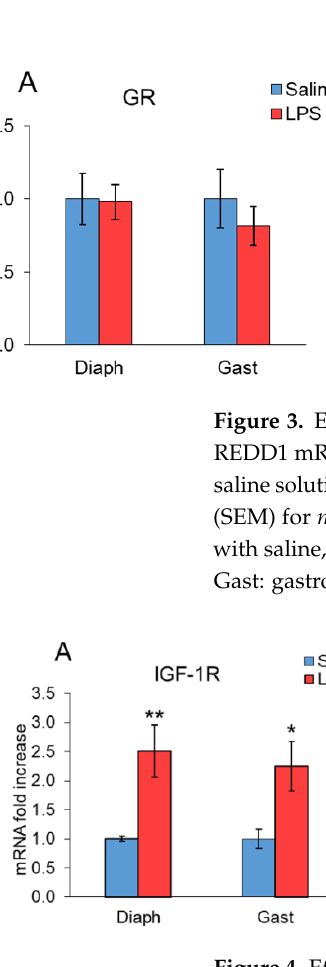
5 of 15 Figure 2. Effect of sepsis induced by LPS injection (10 mg/kg ip.) on ( A ) TNFα, ( B ) IL-10, ( C ) IL-6 and ( D ) SOCS3 mRNA, in rat diaphragm and gastrocnemius muscles, 24 h after a single injection of LPS or saline solution. mRNA was measured by PCR. Data represent mean ± standard error of the mean (SEM) for n = 7 – 8 rats/group. * p < 0.05 and ** p < 0.01 versus their respective control rats treated with saline, # p < 0.05 versus diaphragm of rats treated with LPS. Diaph: diaphragm, Gast: gastrocnemius. The effect of LPS administration on glucocorticoid signaling is shown in Figure 3. LPS administration did not modify GR mRNA levels in the diaphragm or gastrocnemius (Figure 3A). However, an increase in both KLF15 ( p < 0.01, Figure 3B) and REDD1 ( p <